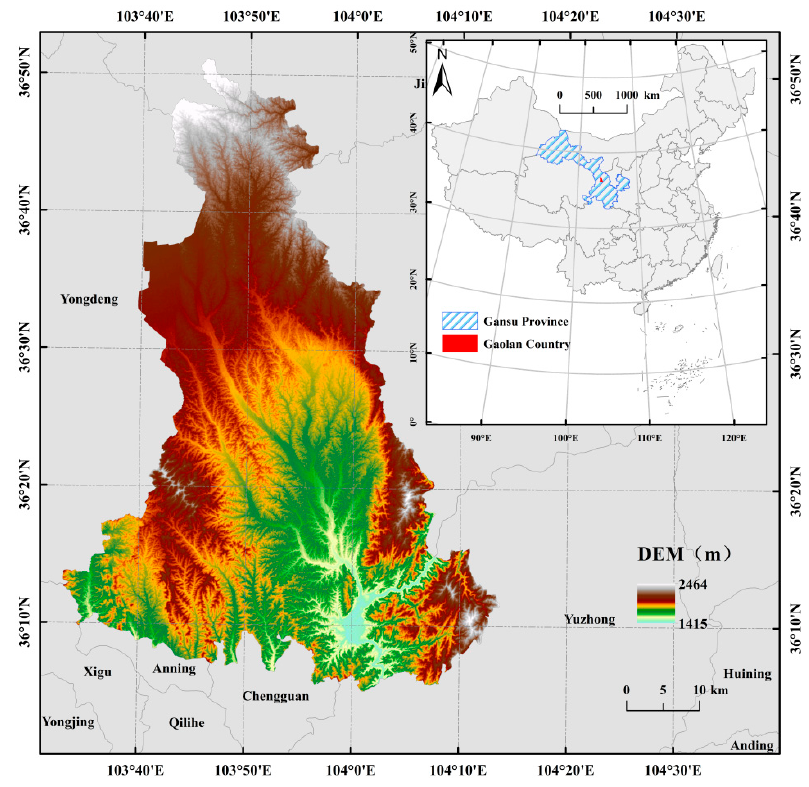
Figure 1. Geographic location of the study area.